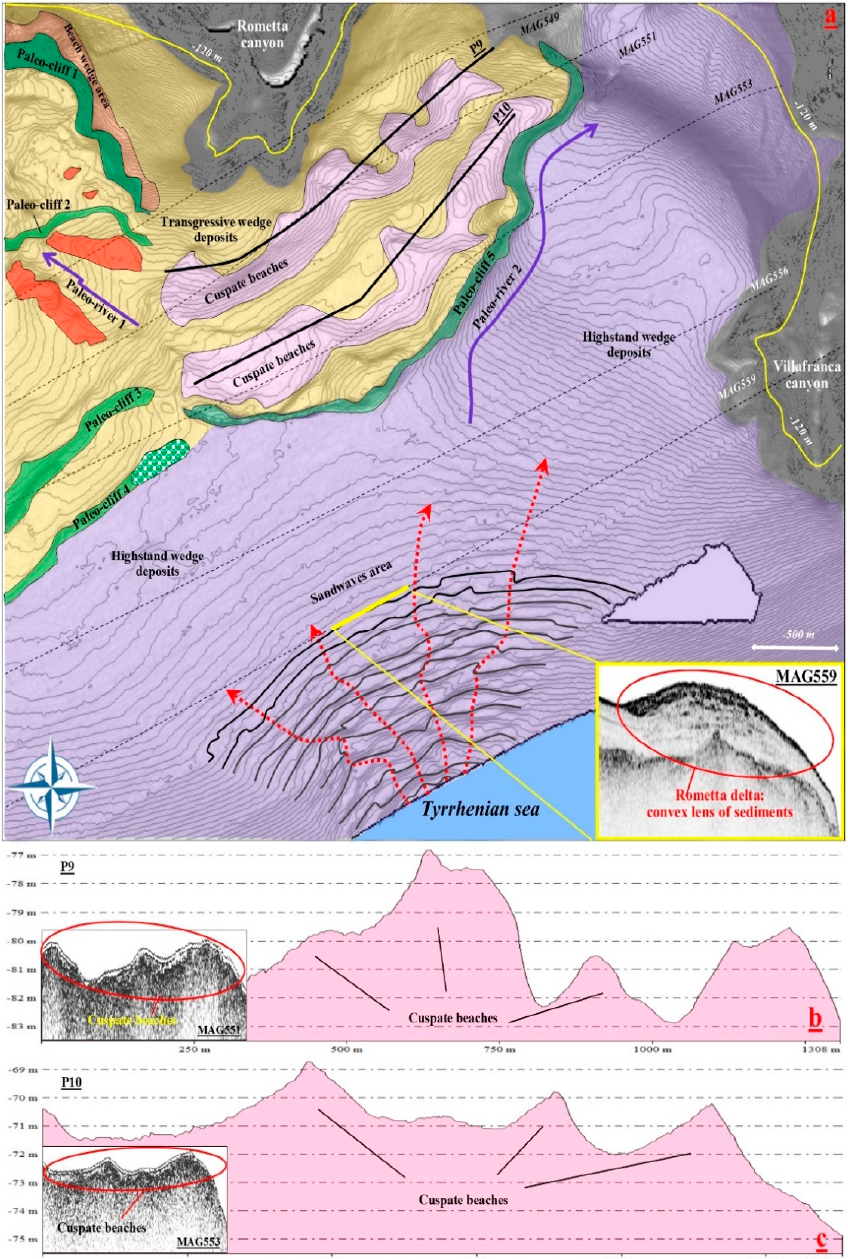
Figure 6. ( a ) Mapping of the main geomorphic elements outcropping on the seabed of the eastern sector of the study area, with particular focus on the relict Transgressive System Tract deposits. ( b ) The P9 bathymetric profile about, longitudinal to the first level of the cuspate beaches. ( c ) The P10 bathymetric profile about, longitudinal to the second level of the cuspate beaches. Southwards, at a depth of 68 m, another paleo-cliff (5) shows an arcuate trend for about 2 km. It displays portions dominated by geomorphic elements attributable to longitudinal coastal paleo-barriers that alternate with flatter areas (gradients < 2°) due to the pellicular coverage of the nearby HST deposits.